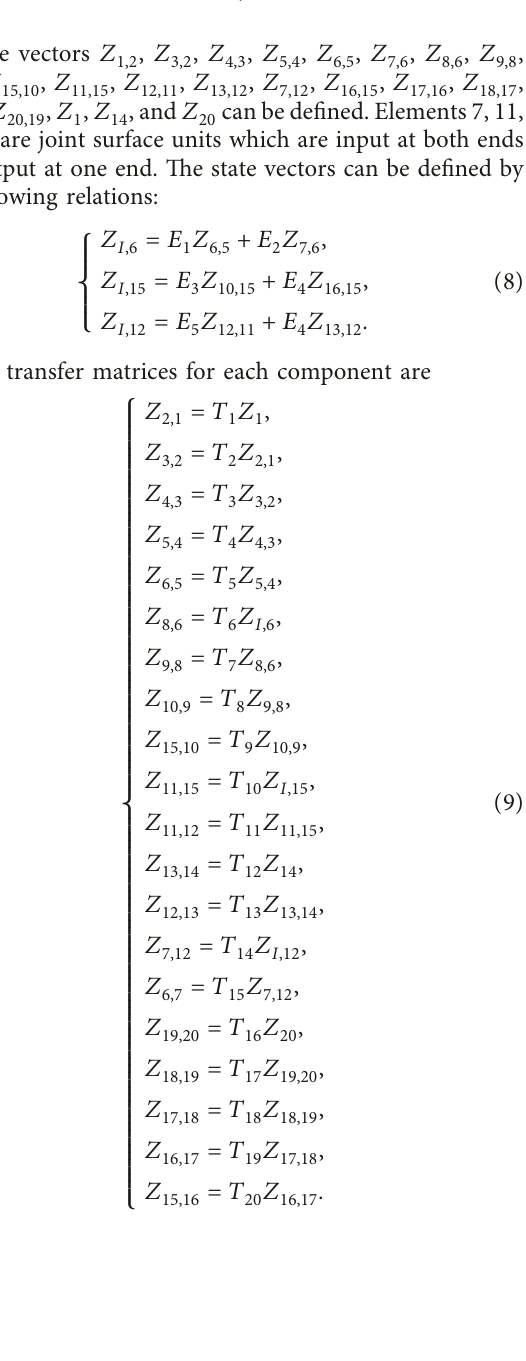
Figure 1: Multibody model of the heavy-duty CNC machine tool-foundation